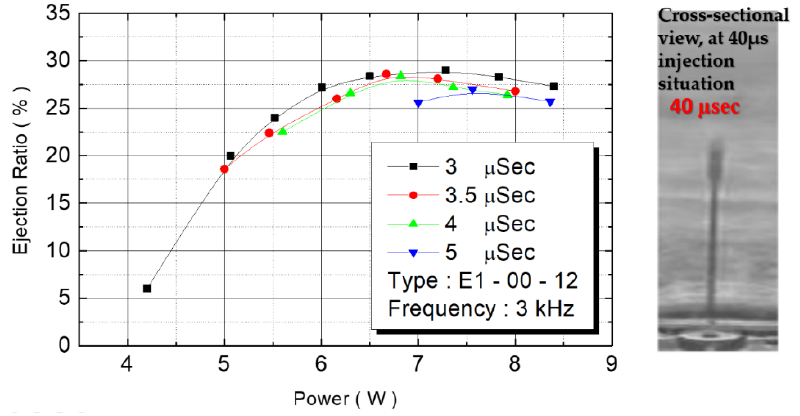
Figure 17. E1 type ejection rate relationship.